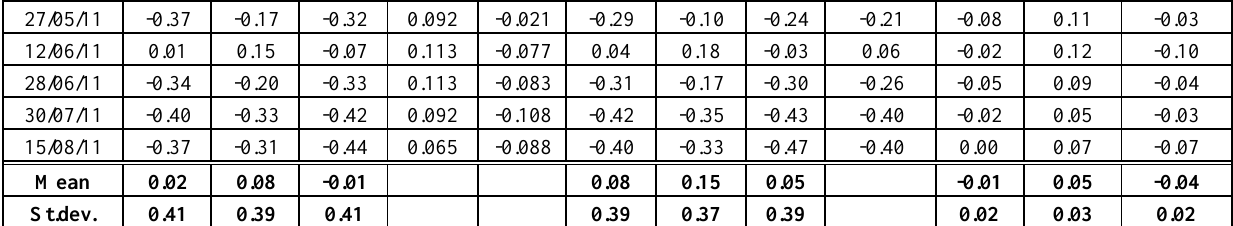
Table 4. Absolute PS’s accuracy assessment for CSK2